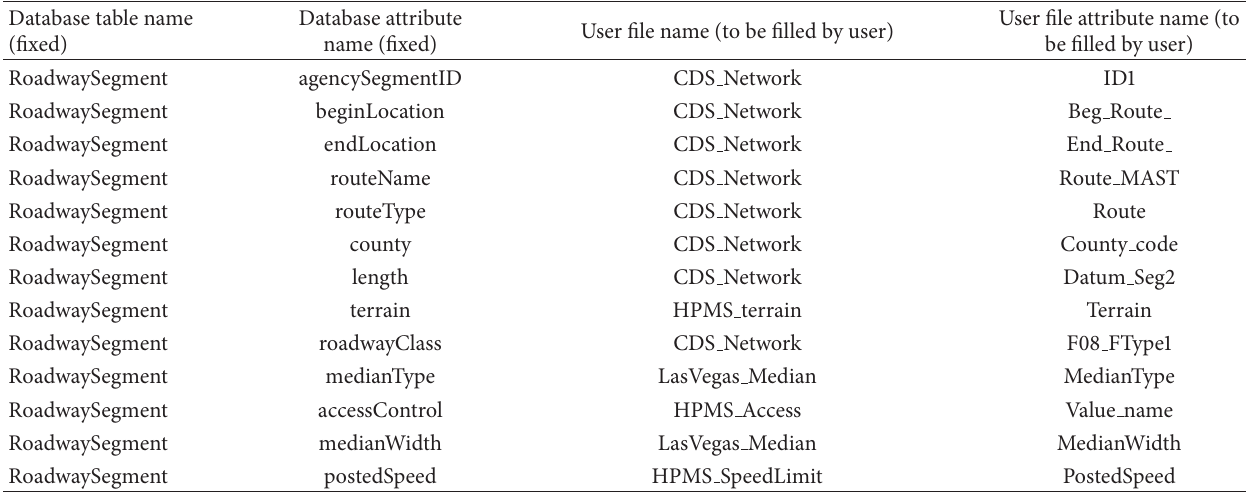
Table 2: Sample of the metadata file for data